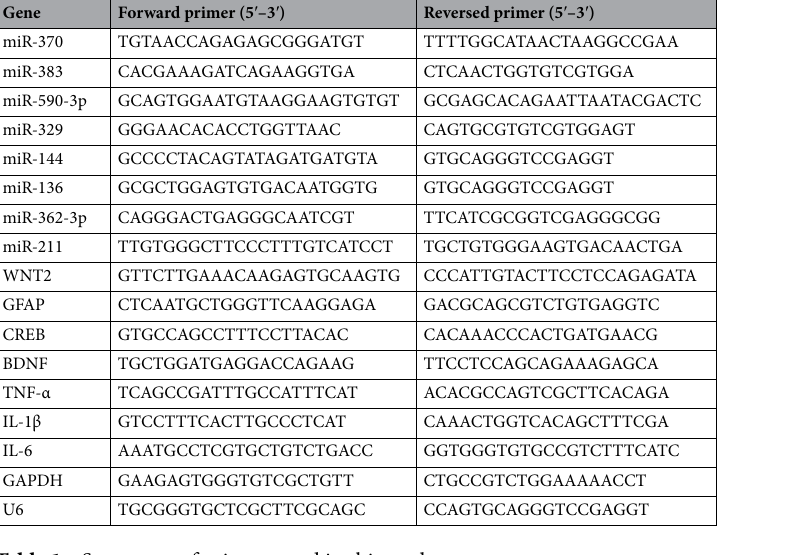
Table 1. Sequences of primers used in this